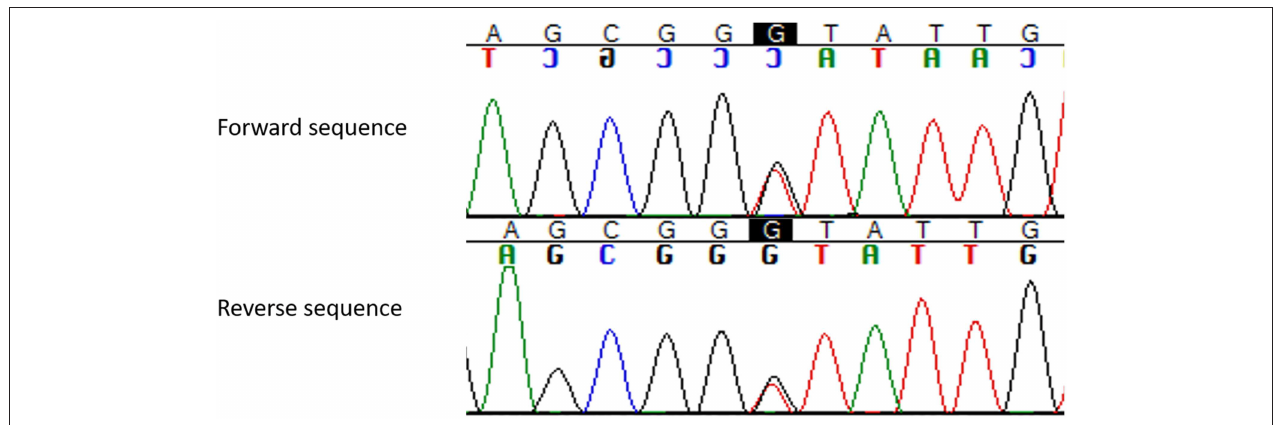
FIGURE 2 | Pathogenic germline MEN1 variant (c.654 + 1G > T, IVS3, g.3405G > T) identified in the present MEN1 case reported with hydrocephalus and intracranial hypertension for giant prolactinoma. The change in heterozygous of the nucleotide guanine for timine at the canonic region + 1 of the intron 3 of the MEN1 gene (c.654 + 1G > T; HGMD: CS982266; dbSNP: rs794728622) results in a splicing donor variant (ref. seq: ENST00000312049; NM_130799).